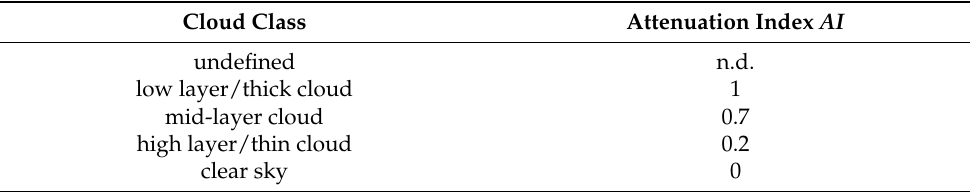
Table 3. The five cloud classes received from cloud segmentation are mapped to values of the attenuation index AI . These approximate values of attenuation index reflect our experience and are used in an intermediate step. Exact values of cloud attenuation are determined based on AI later in Section